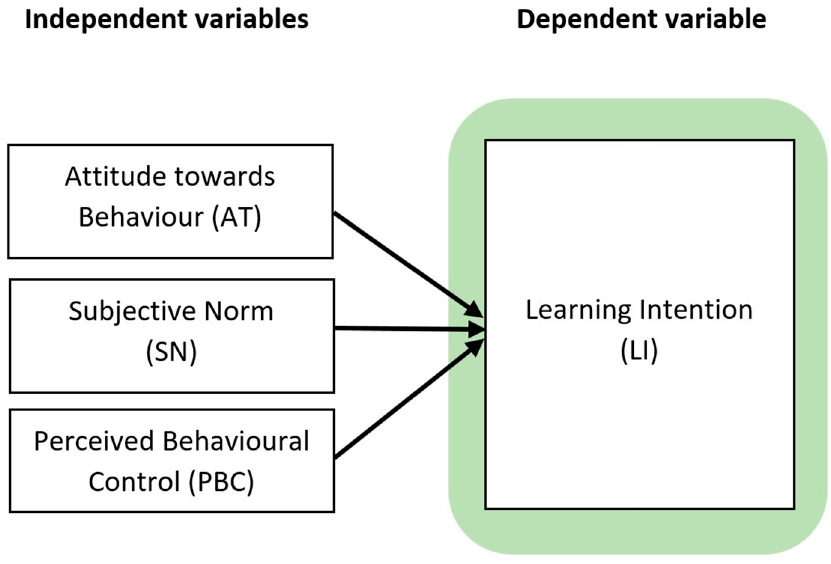
Figure 1. TPB model for this study.